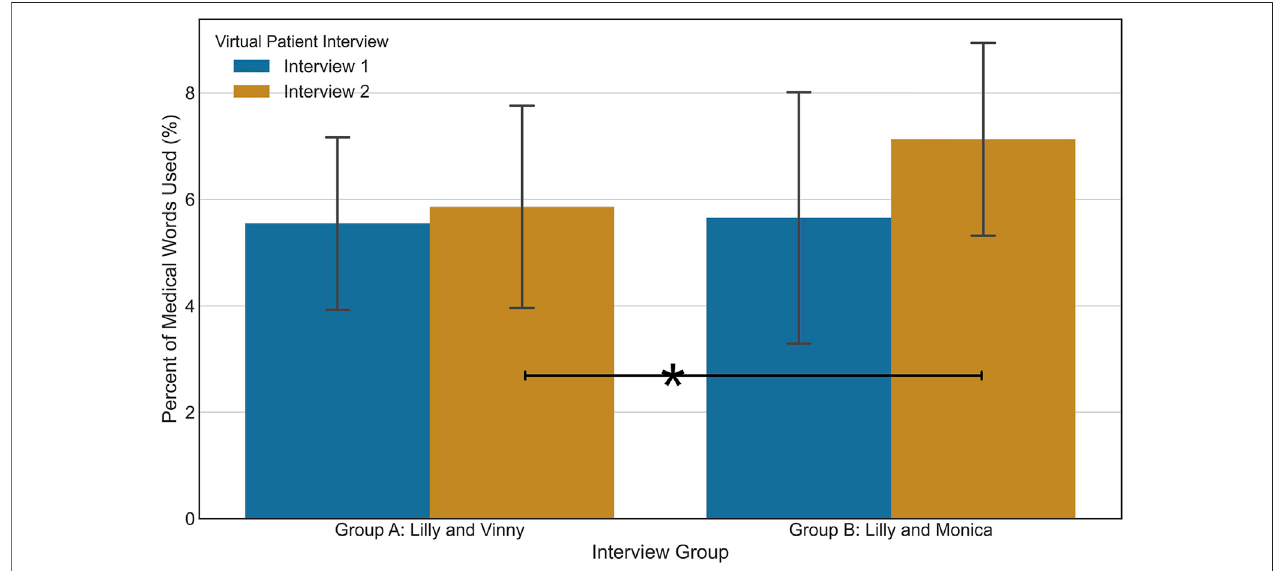
FIGURE 8 | The means and standard deviations of percent of medical words used for students in the Message Production Trends study.